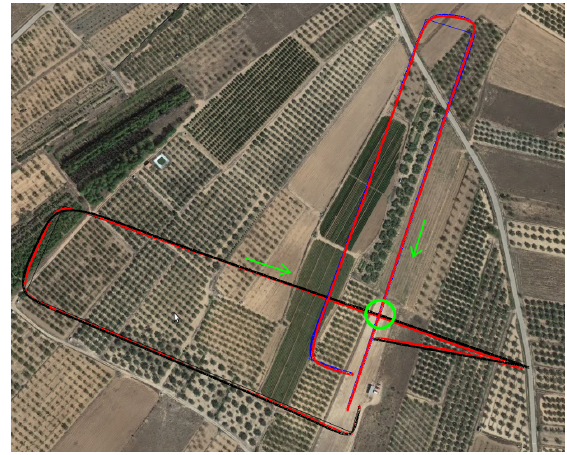
Figure 13. Simulation vs. real experiment in a perpendicular crossing (scenario